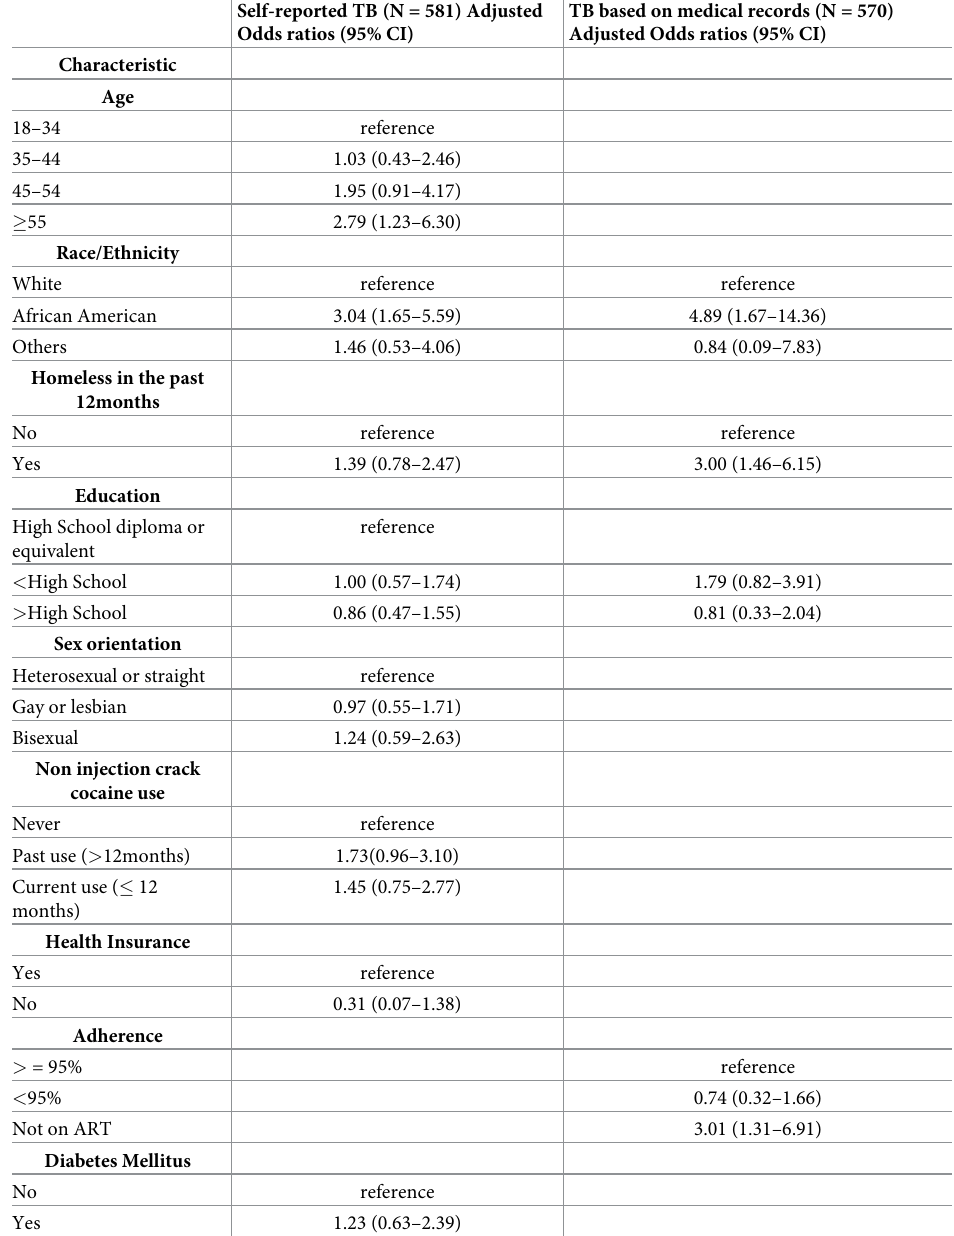
Table 3. Multivariable logistic regression analysis of the association between risk factors in persons living with HIV in Florida and data sources on TB diagnosis. Self-reported TB (N = 581) Adjusted TB based on medical records (N = 570) Odds ratios (95% CI) Adjusted Odds ratios (95%